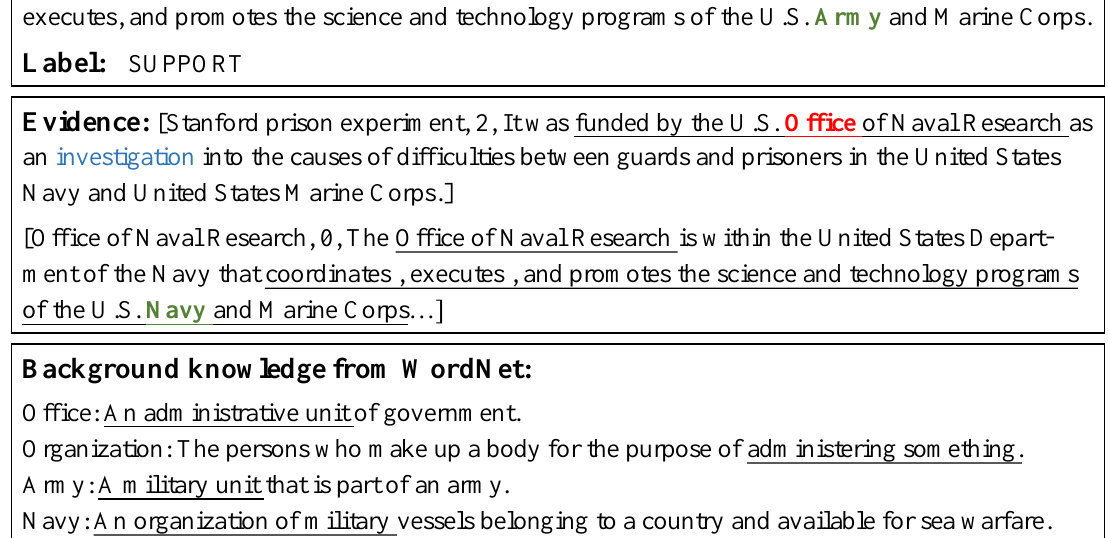
Figure 1. An example from FEVER. The format of evidence is [Document name (Wikipedia), line number, evidence content], which denotes the evidence is extracted from the “line number” of article “Document name”. Words highlighted in the claim and evidences refer to those that are not easily understood by the model. The underlined words in the evidences and background knowledge are crucial information to verify the